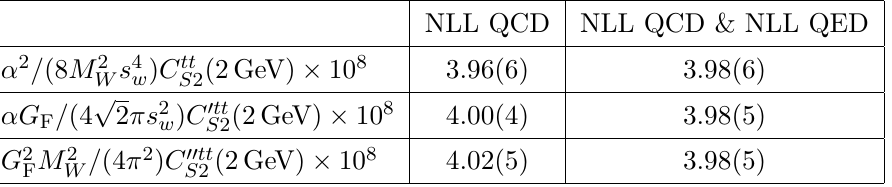
Table 2 . Wilson coefficients. Uncertainty given is scale variation